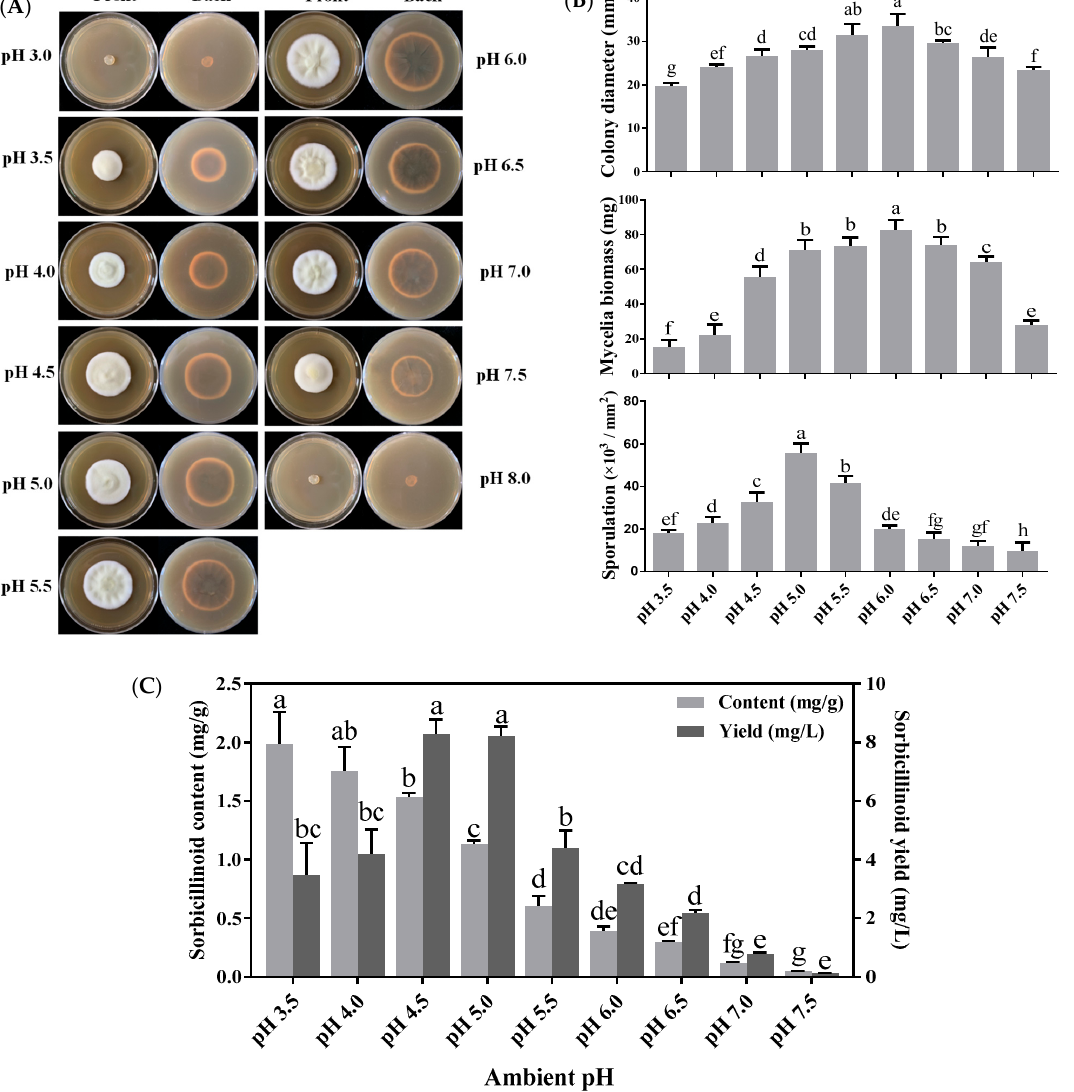
Figure 3. Effects of ambient pH on colony extension, mycelial growth, sporulation and sorbicillinoid production of U. virens . ( A ) Colony morphology of U. virens, cultured for 18 days at 28 °C on PBGY medium, with different ambient pH values; ( B ) Effects of ambient pH on colony diameter, mycelial biomass and sporulation of U. virens ; ( C ) Effects of different ambient pH values on sorbicillinoid content (mg/g) and yield (mg/L). Bars represent standard deviations of the means. Di ff erent le tt ers mean signi fi cant di ff erences according to Duncan’s Multiple Range Test ( p < 0.05).